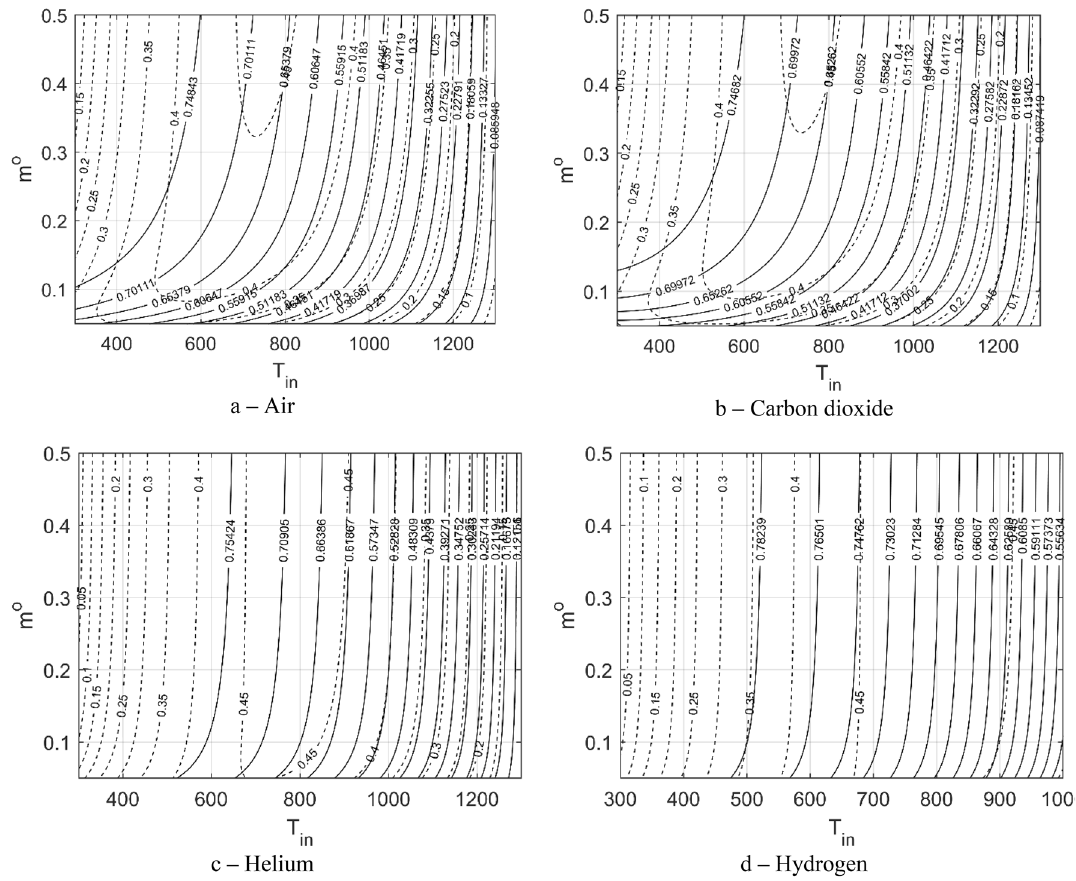
Figure 4. Level curves of the gase performance in terms of the inlet temperature and mass flow rate.